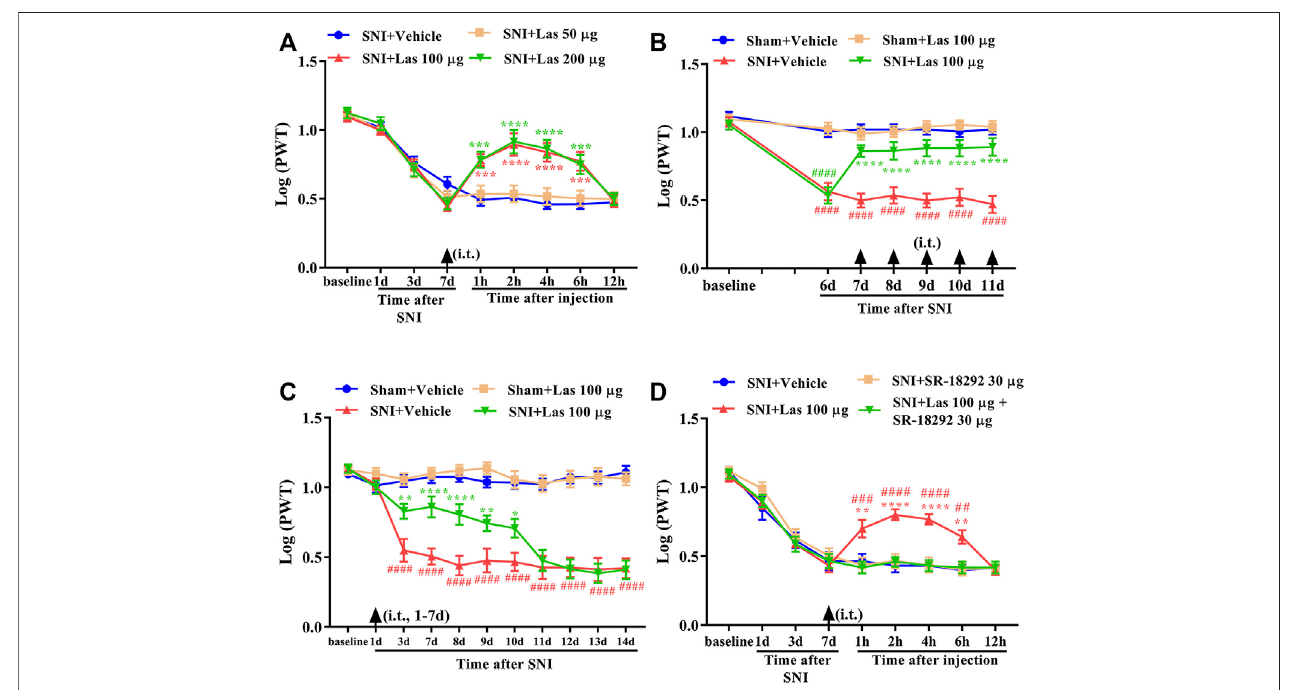
FIGURE6| Analgesiceffectof5-HT 1F receptoragonistonmechanicalallodyniainneuropathicpainrats. (A) Asingledoseoflasmiditan(100and200 μ g)markedly increasedthePWTinSNIrats,beginningat1h,peakingat2h,andlastedforatleast6 h( Figure7A ,*** p < 0.001,**** p < 0.0001comparedwithSNI+Vehiclegroup,n= 10 in each group). (B) Repetitive injections of lasmiditan (100 μ g, i. t.) considerably reversed established mechanical allodynia in SNI rats (**** p < 0.0001 compared with SNI + Vehicle group, #### p < 0.0001 compared withSham + Vehicle group, n =10 in each group). (C) The PWT was signi fi cantly increased from day 3 to day 10 in lasmiditan-treated SNI rats compared with vehicle-treated SNI rats (* p < 0.05, ** p < 0.01, **** p < 0.0001 compared with SNI + Vehicle group, #### p < 0.0001 compared with Sham + Vehicle group, n = 10 in each group). (D) The analgesic effectof lasmiditan was entirely reversed by PGC-1 α inhibitor SR-18292 (** p < 0.01, **** p < 0.0001 compared with SNI + Vehicle group, ## p < 0.01, ### p < 0.001, #### p < 0.0001 compared with SNI + Las 100 μ g + SR-1892 30 μ g group, n = 10 in each